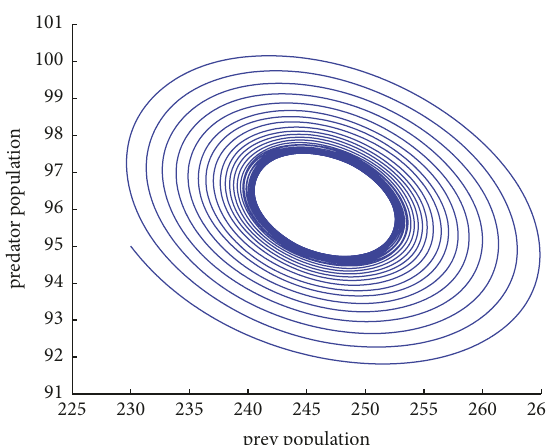
Figure 19: The phase portrait of delayed model (3) with the time delay 𝜏 1 = 𝜏 2 = 0.19 . The parameters are taken as 𝑥(0) = 230 , 𝑦(0) = 95 , 𝐴 = 0.01 , 𝑟 = 2.65 , 𝐾 = 900 , 𝑎 = 0.02 , 𝑐 = 0.215 , and 𝑚 = 1.06 ; 𝐸 = (𝑥 , 𝑦 ) becomes unstable; a limit cycle is ∗ ∗ ∗